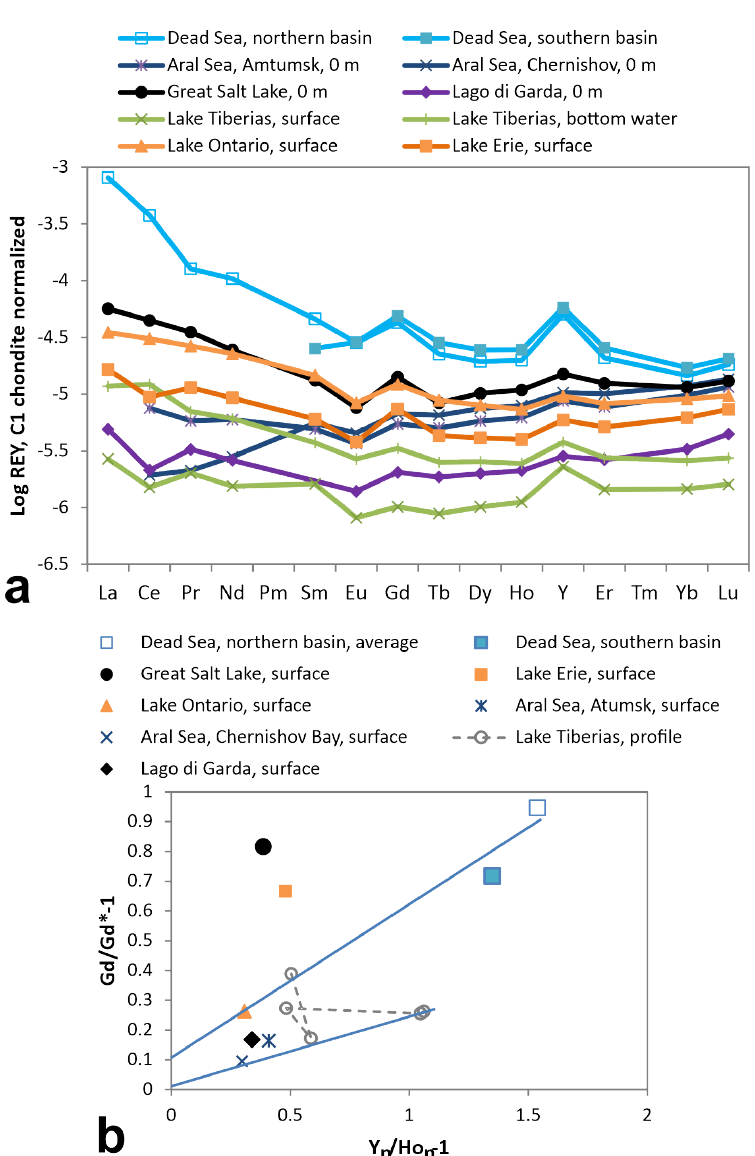
Figure 5. REY in lakes. C1 chondrite-normalized rare earths and Y distribution patterns of lakes and continental seas. ( a ) REY patterns of Lake Erie and Ontario are taken from [66]; Aral Sea (unpublished); Great Salt Lake (unpublished); Lago di Garda (unpublished); Lake Tiberias [67]; Dead Sea [65]. ( b ) Pos- sible correlations between Gd and Y anomalies. Data for stratified Lake Tiberias are taken from [67]. Upper and lower tentative trends are given with slopes of about 0.7 and 0.3,